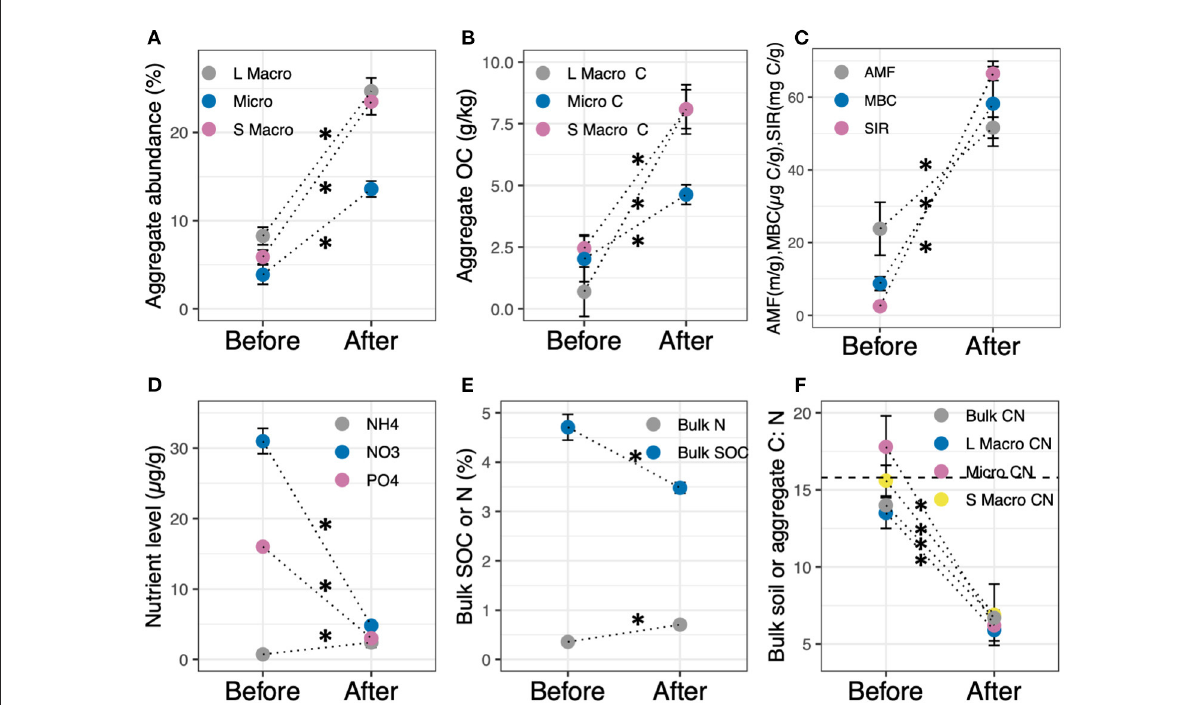
FIGURE1 Levels of (A) WSA, (B) aggregate OC, (C) microbial factors, (D) plant-available N and P, (E) bulk soil C and N, and (F) bulk soil and aggregate C:N before and after site conversion. Horizontal line in (F) denotes plant C:N. Vertical bars indicate the standard error of the mean. For each soil property, means denoted * differ significantly before and after conversion at p < 0.05.